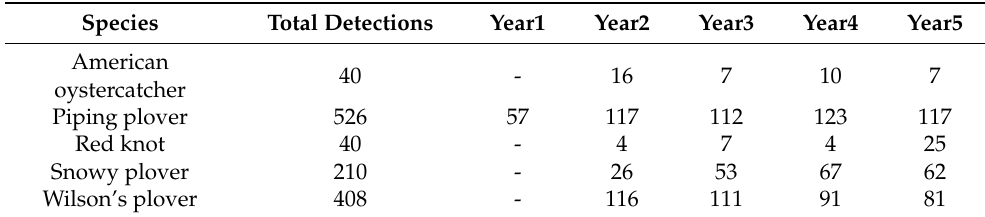
Table 1. Summary of shorebird observations showing the total number of birds sighted for total detections.